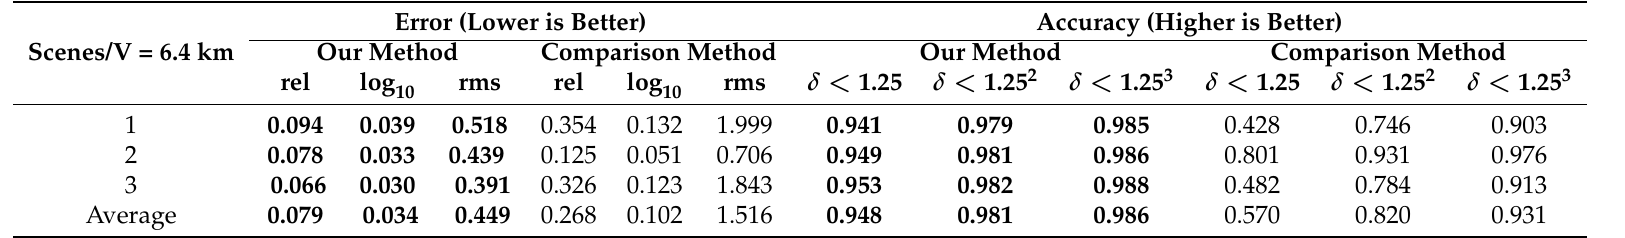
Table 1. Error and accuracy metrics of the first quantitative comparison method (V = 6.4 km).